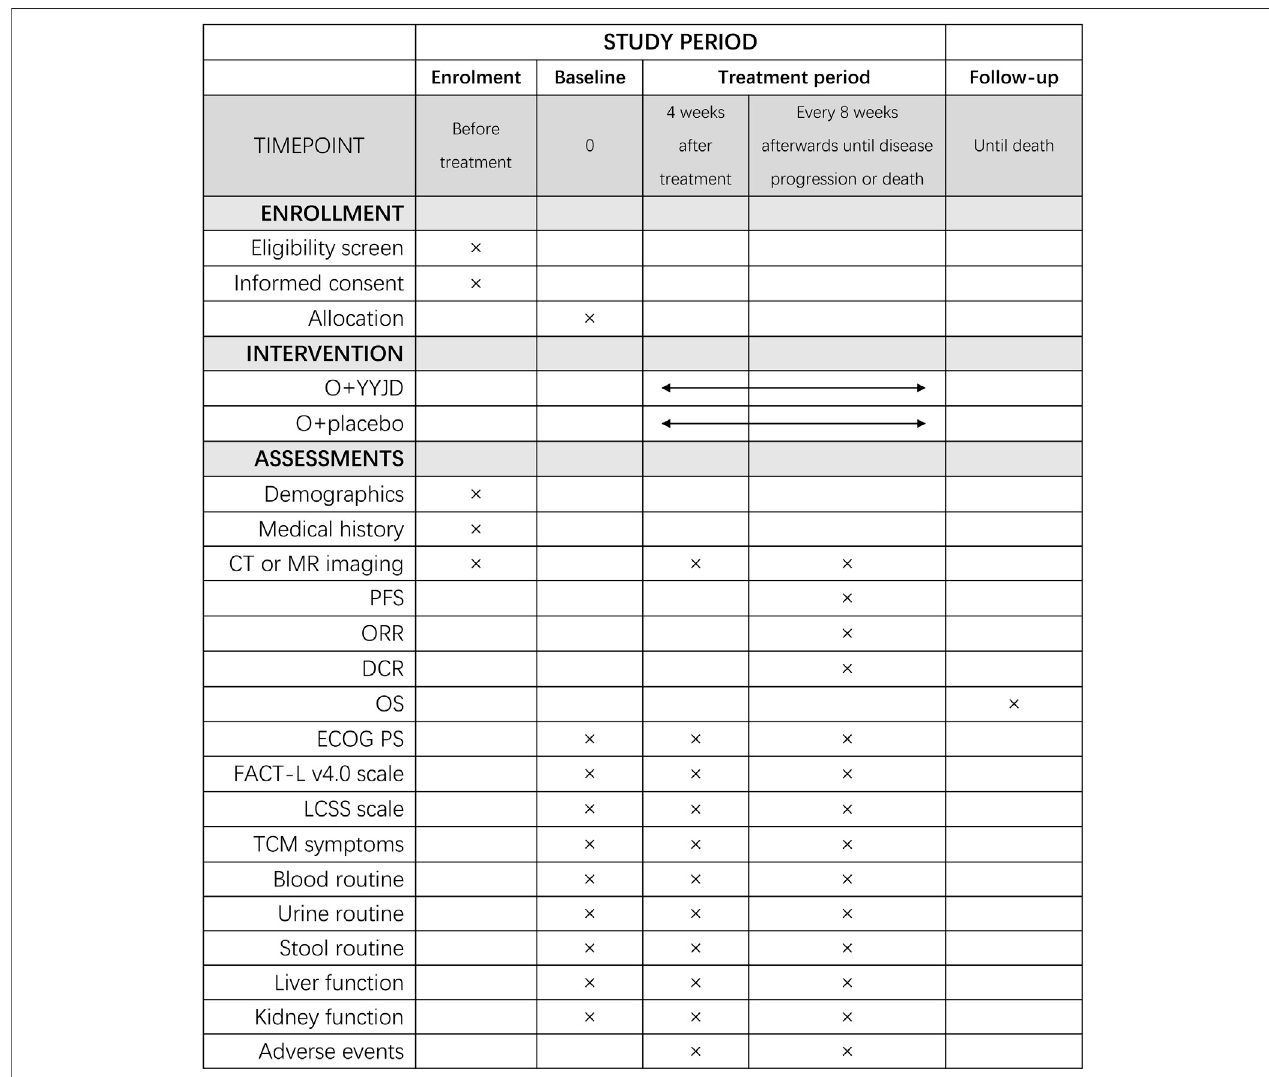
FIGURE 2 | The schedule of enrolment, interventions, and